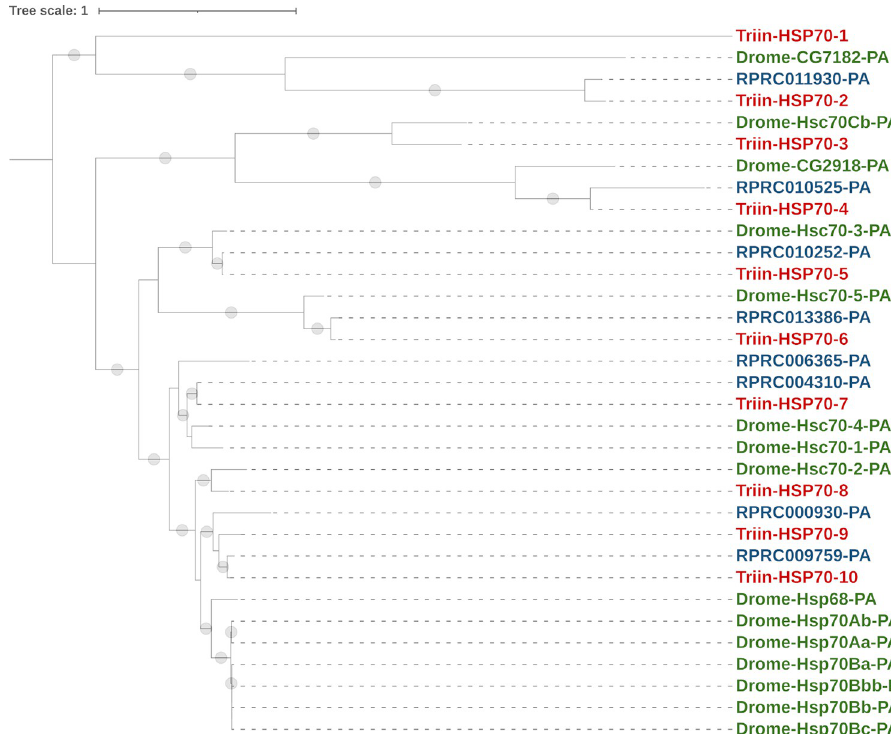
Fig 4. Phylogenetic tree of the HSP70 superfamily from T . infestans , R . prolixus and D . melanogaster . The maximum-likelihood tree was constructed using IQ-Tree and protein sequences obtained from T . infestans transcriptome (Triin-, red, available in Table F in S2 File) and from R . prolixus (RPRC-, blue, VectorBase ID is shown) and D . melanogaster (Drome-, green, FlyBase gene name and isoform are shown) genomes. Rhodnius prolixus chimeric sequence and those shorter than 250 amino acids were excluded from the analysis (Table F in S2 File). Triatoma infestans sequences were numbered according to their position in the tree. Branches with SH-aLRT support values > 80 are marked with a grey dot. The tree was rooted at midpoint.